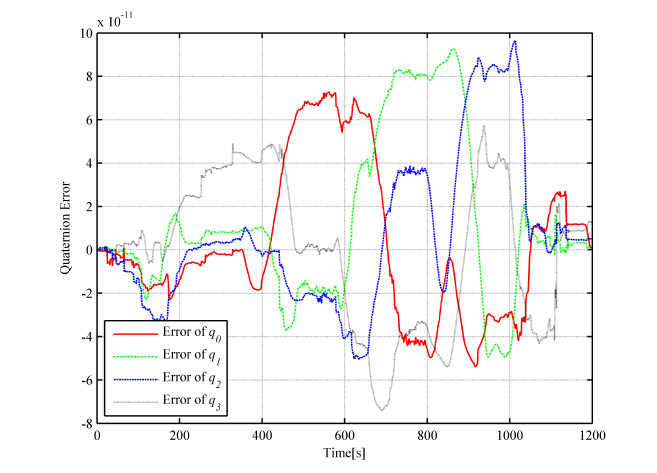
Figure 3. Curve of the quaternion error (based on